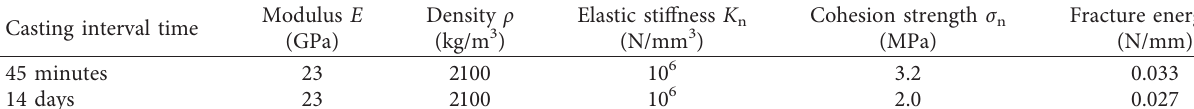
Table 5: Parameters of the cohesive element to simulate the C-ITZ.